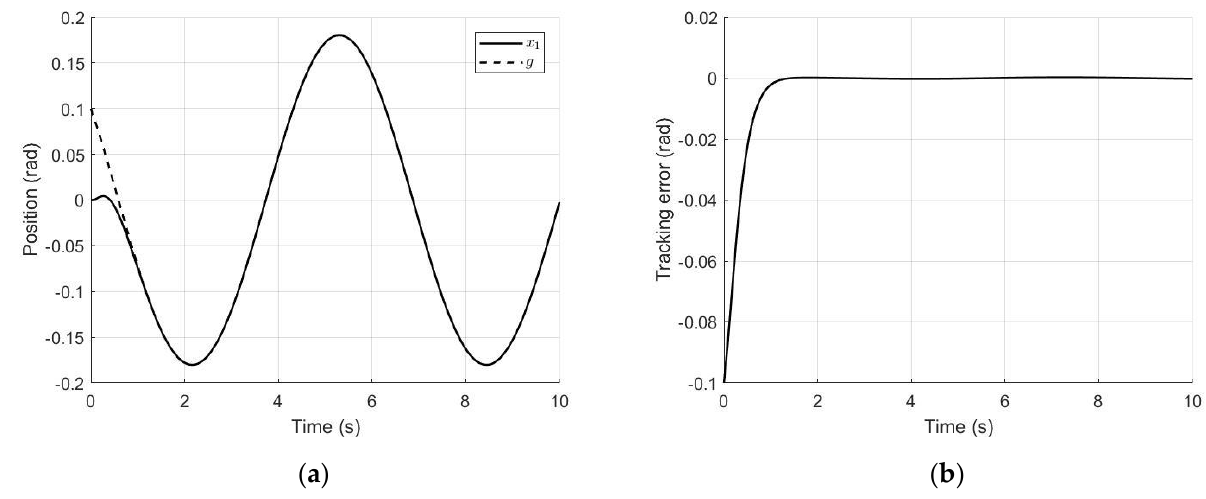
Figure 15. Experiment 4. In ( a ), plots of the reference signal g ( t ) and the output x 1 ( t ) ; in ( b ), plot of the tracking error e 1 = x 1 ( t ) − g ( t ) .